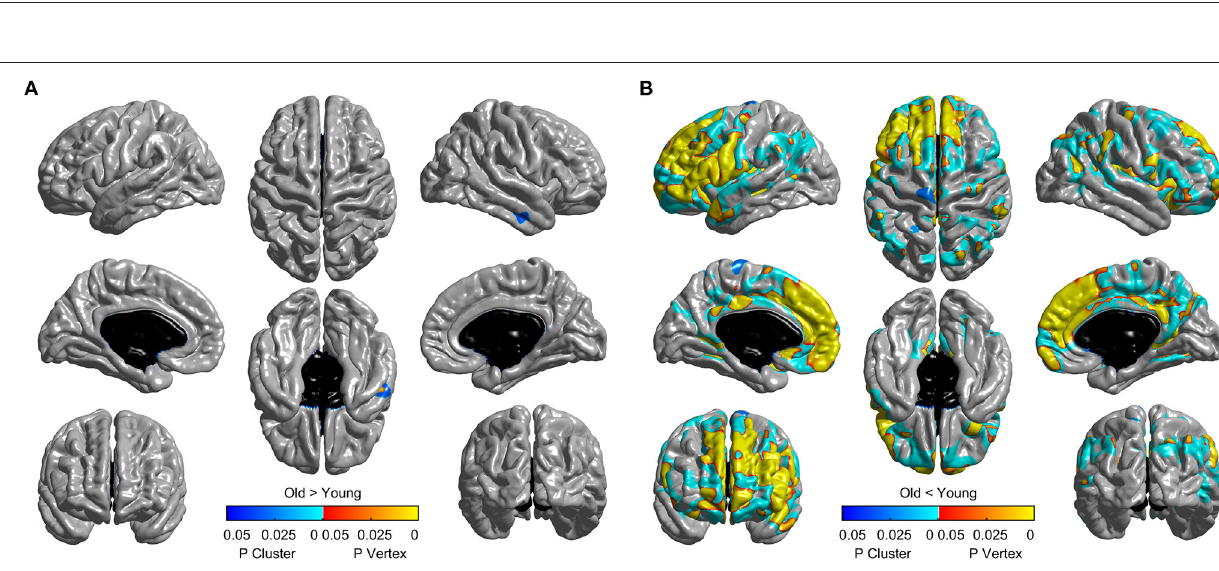
of old adults: 2.44 mm, mean of young adults: 2.59, p <